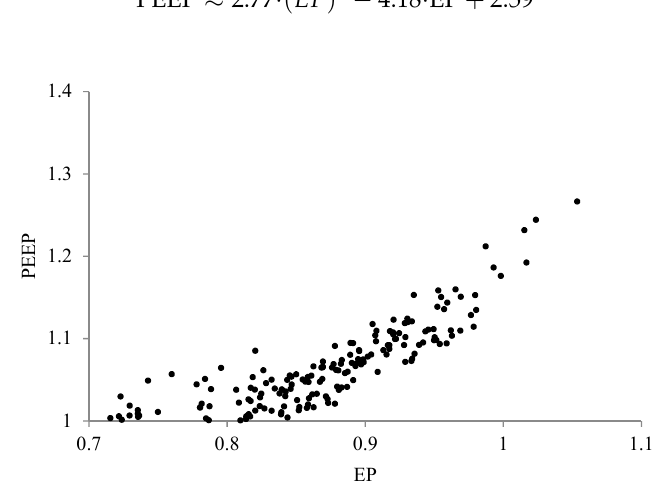
Figure 7. Scattering of PEEP and EP.